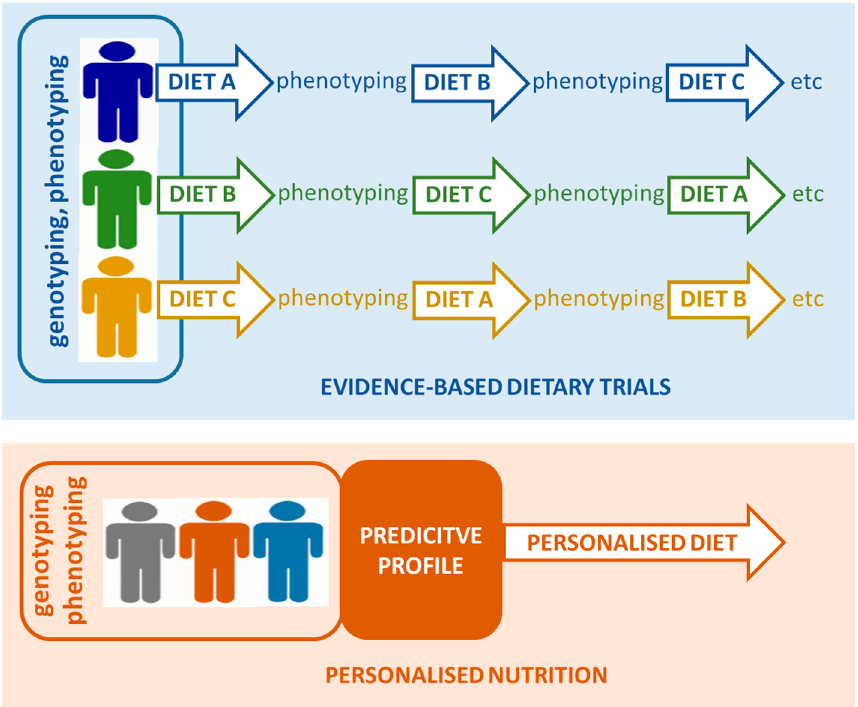
Figure 1. Concept of n-of-1 trials leading to personalised interventions.